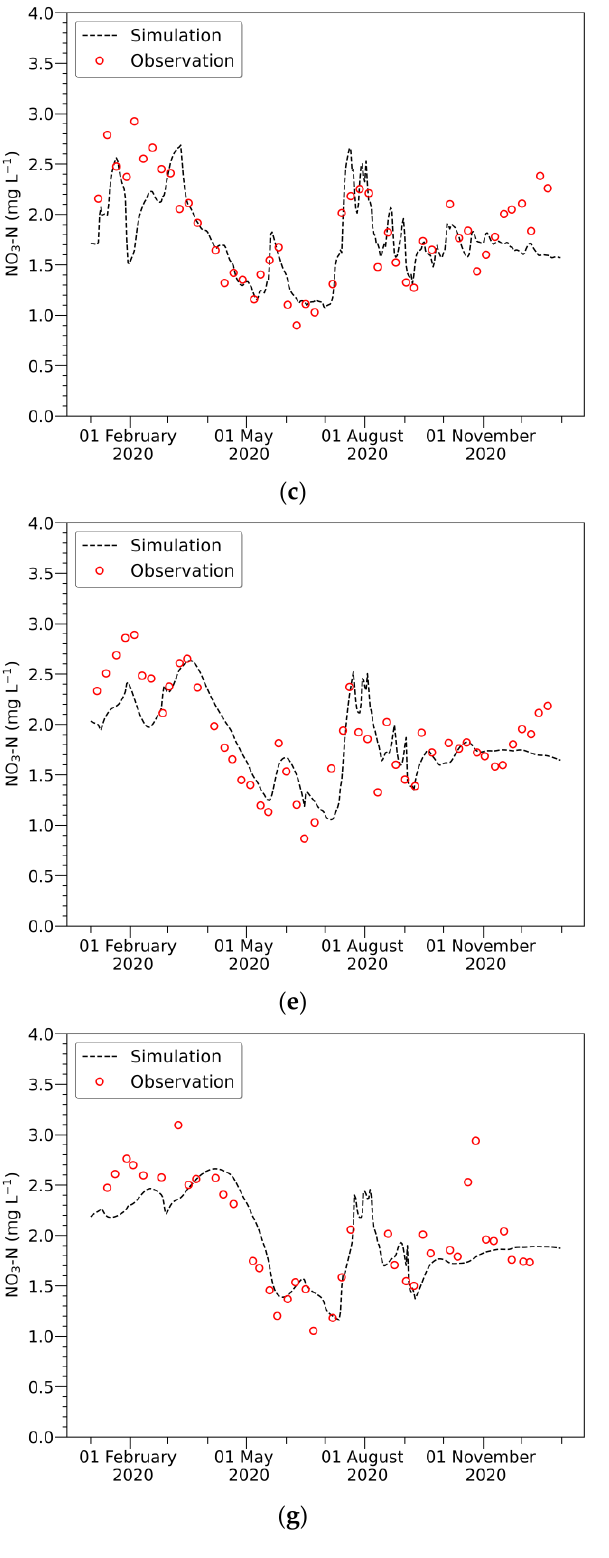
Figure 7. Graphs showing the difference between simulation and observation of the NO 3 -N concentration for validation. ( a ) Cross section 658; ( b ) cross section 620; ( c ) cross section 559; ( d ) cross section 517; ( e ) cross section 503; ( f ) cross section 459; ( g ) cross section 427; ( h ) cross section 416.